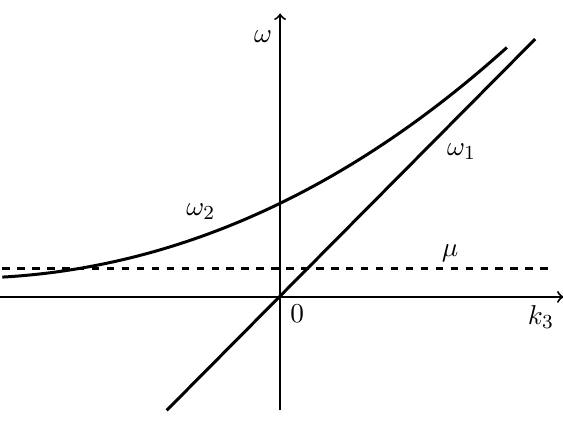
Figure 2 . Energy levels ! 1 ( k 3 ) and ! 2 ( k 3 ) for single-particle states, obtained from the e(cid:11)ective theory of equation